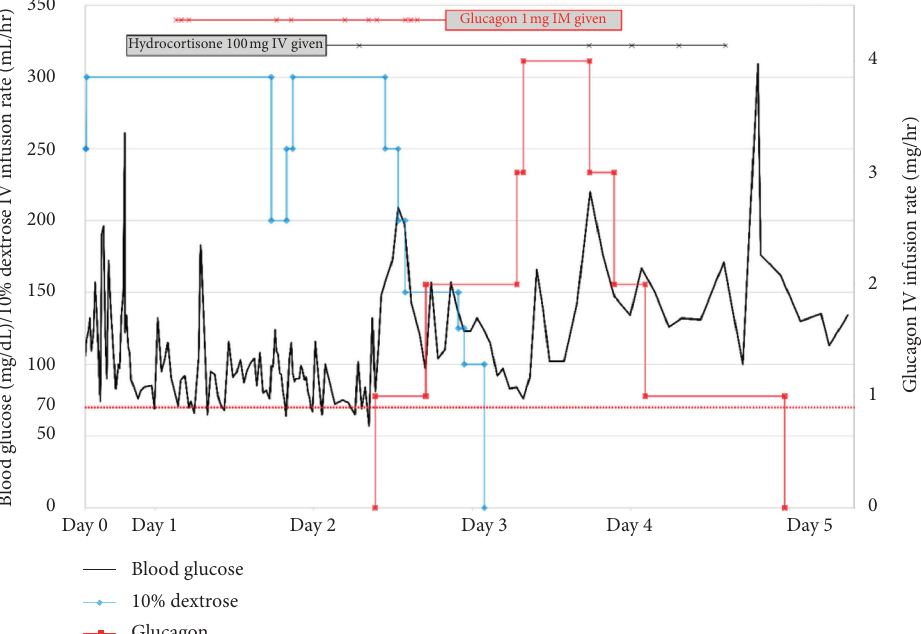
Figure 1: Blood glucose trends over time starting at ED presentation (black line, left axis), along with IV dextrose infusion rate (blue line, left axis), IV glucagon infusion rate (red line, right axis), hydrocortisone IV doses (black horizontal line across the top), and glucagon IM doses (red horizontal line across the